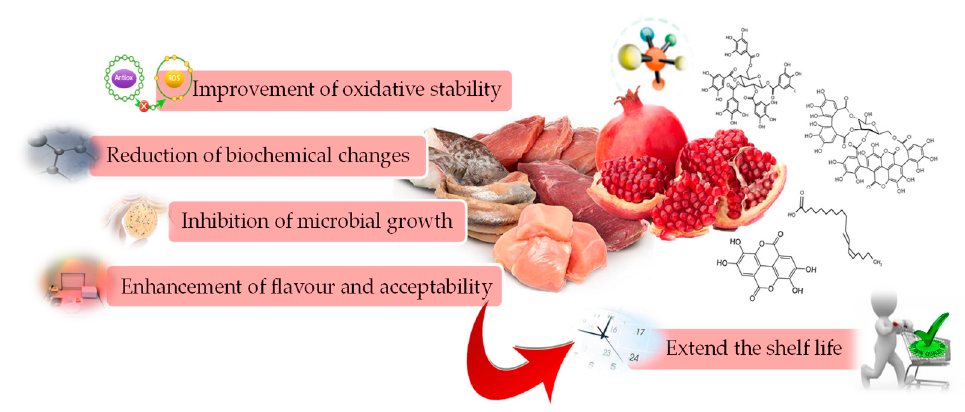
Figure 3. Effect of biomolecules from pomegranate by-products on quality attributes of muscle foods. Many researchers have also indicated the beneficial use of components from pomegranate wastes in preserving colour and aroma, and maintaining the sensory attributes of muscles foods. A summary of various bioactive compounds from pomegranate wastes used in muscle foods and their impact on the quality and safety of prepared products is presented in Table 4. Table 4. A summary of the various bioactive compounds from pomegranate wastes used in muscle foods and their impact on the quality and safety of prepared products.